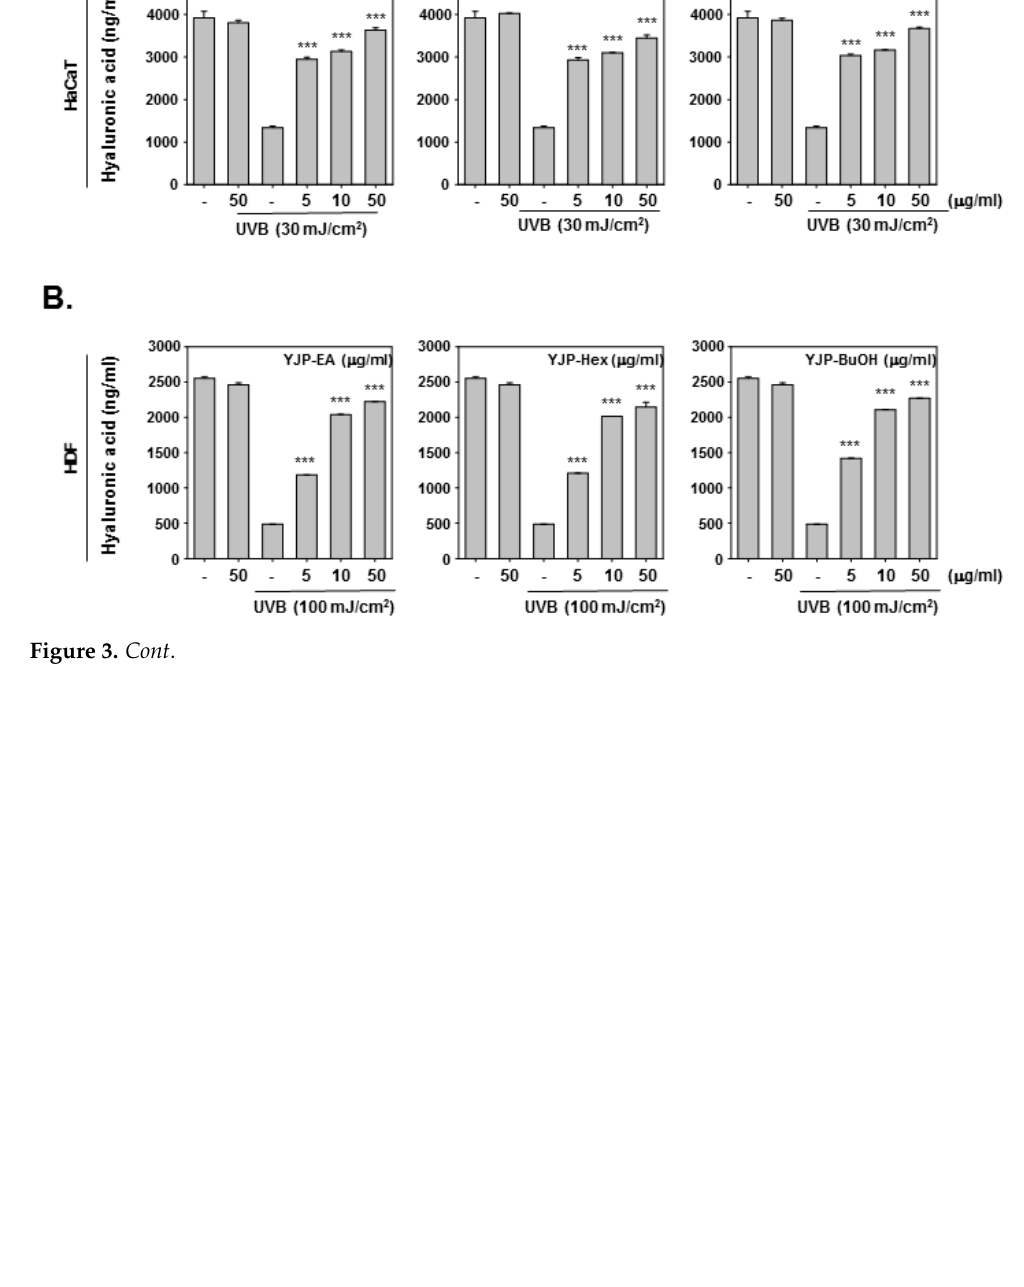
Figure 3. Moisture-recovery effects of YJP-EA, Hex, and BuOH on UVB-damaged HaCaT and HDF cells. ( A , B ) HaCaT and HDF cells were irradiated with UVB (30 or 100 mJ/cm 2 ) and treated with YJP-EA, Hex, and BuOH for 24 h. The hyaluronic acid was measured using a hyaluronan ELISA kit and detected with 450 nm. ( C , D ) The protein-expression levels of filaggrin and SPT were analyzed by Western blot analysis. All experiments were performed individually in tripli- cate. *** p < 0.001 vs. non-treated (NT) cells.